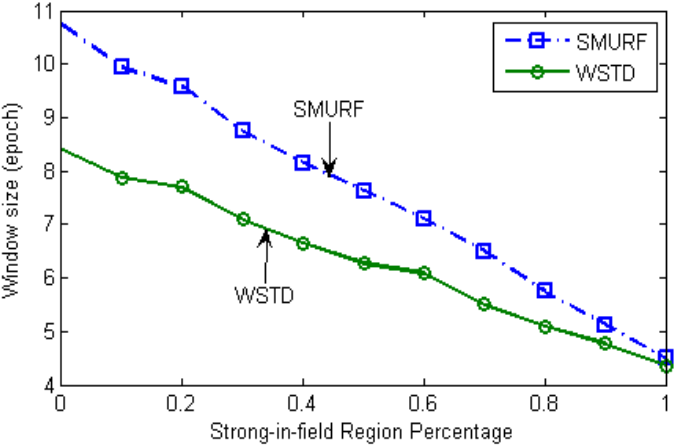
Figure 8. Comparison of WSTD and SMURF schemes’ cleaning-window sizes as the environment noise is varied.